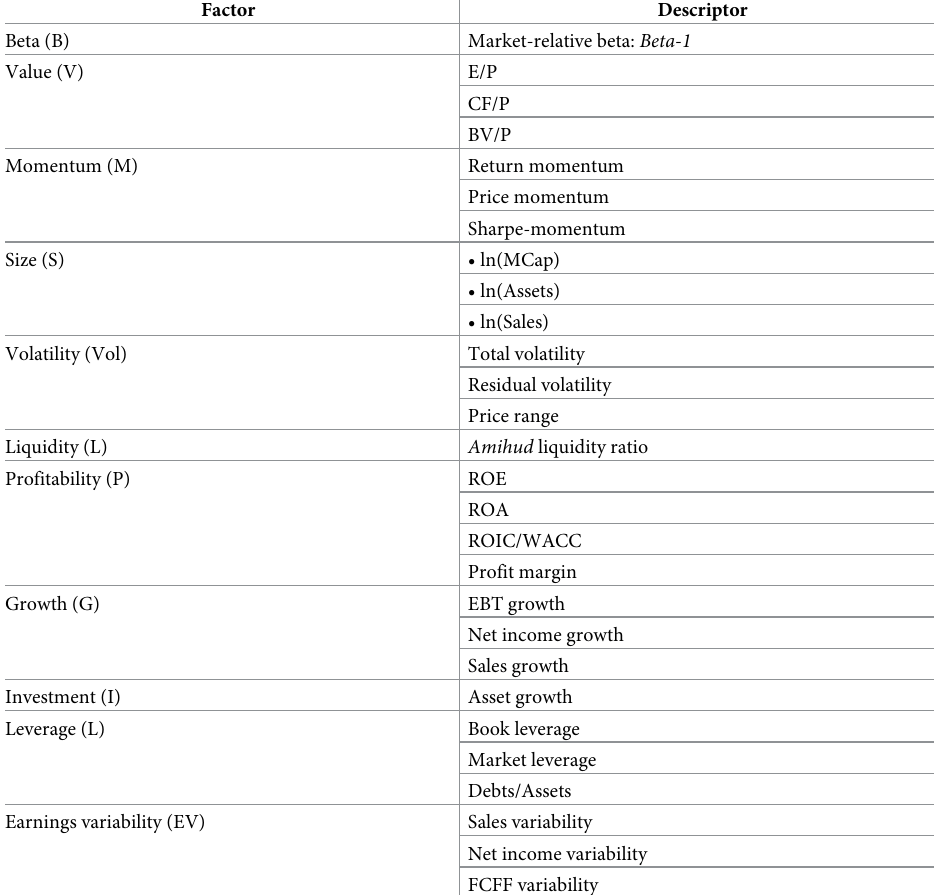
Table 2. Pure style factors and factor-related descriptors.